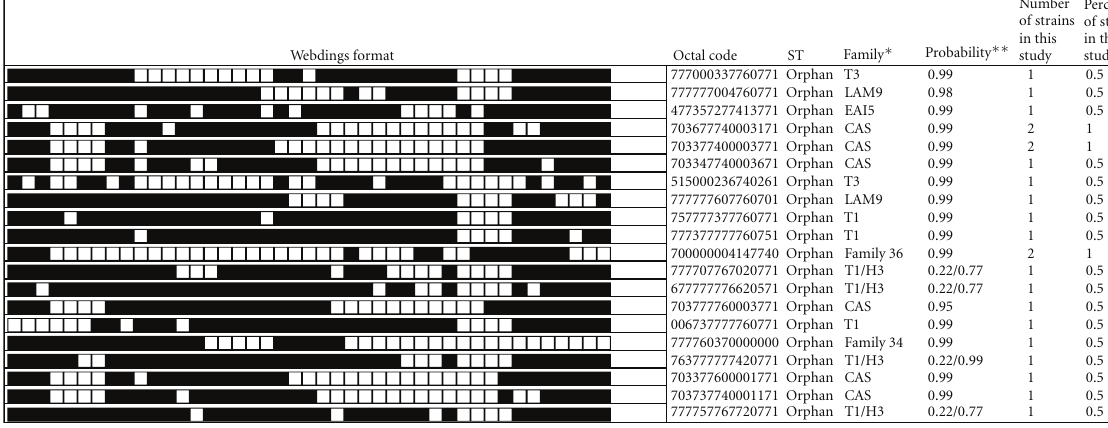
Figure 2: Spoligotype pattern of orphan M. tuberculosis strains from HIV-positive and HIV-negative patients. ∗ SpotClust-program-assigned family. ∗∗ Probability that the spoligotype pattern belongs to the family.